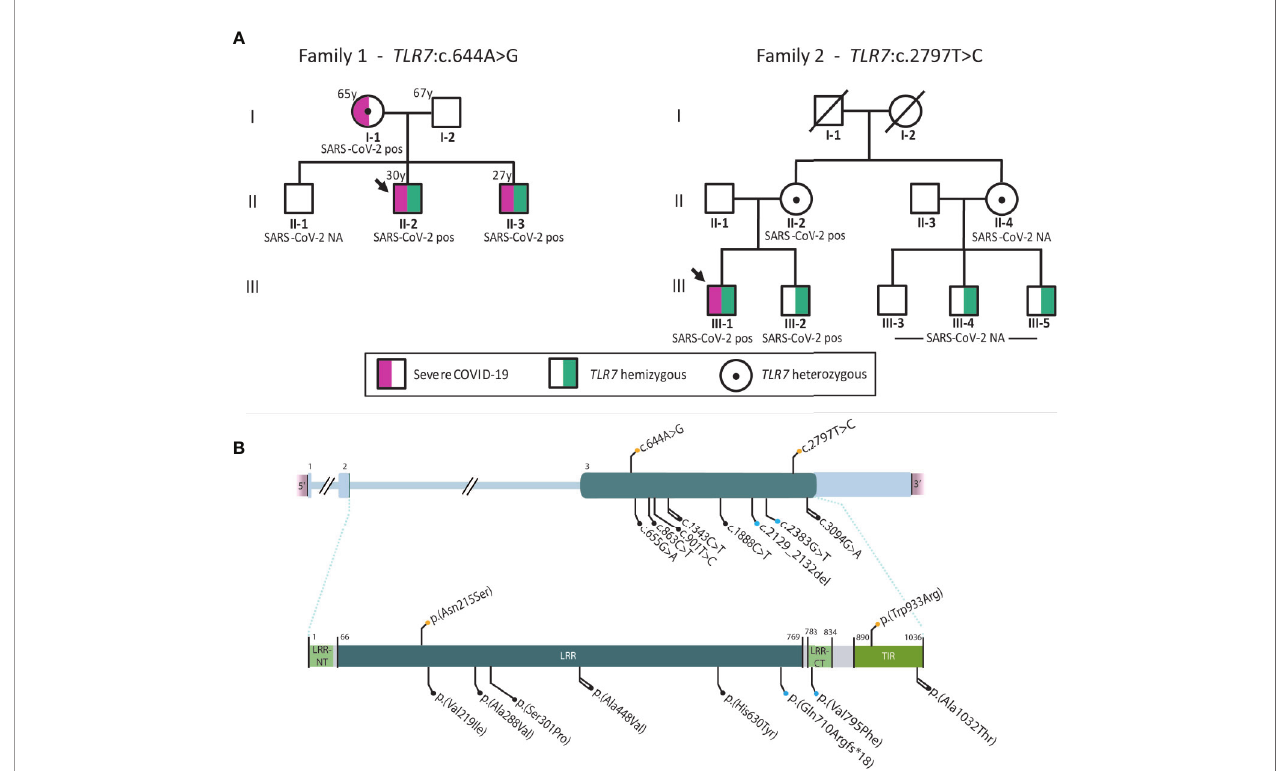
( Table 2 ). The patient received antiviral treatment with remdesivir and immunosuppressive therapy with